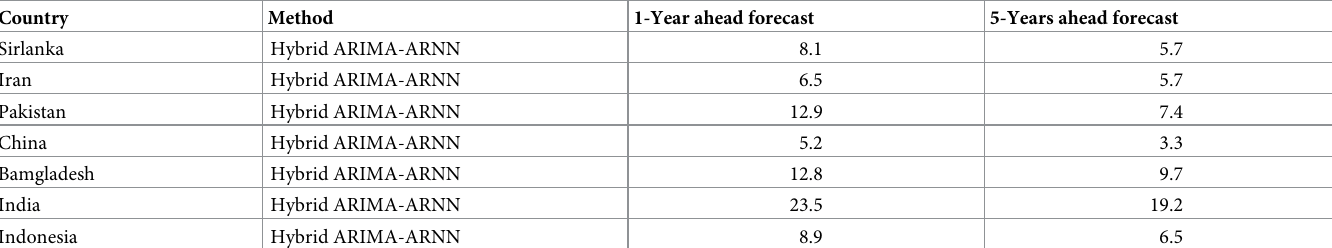
Table 4. One and five-years ahead point projection based on the best hybrid model for developing countries of Asia.